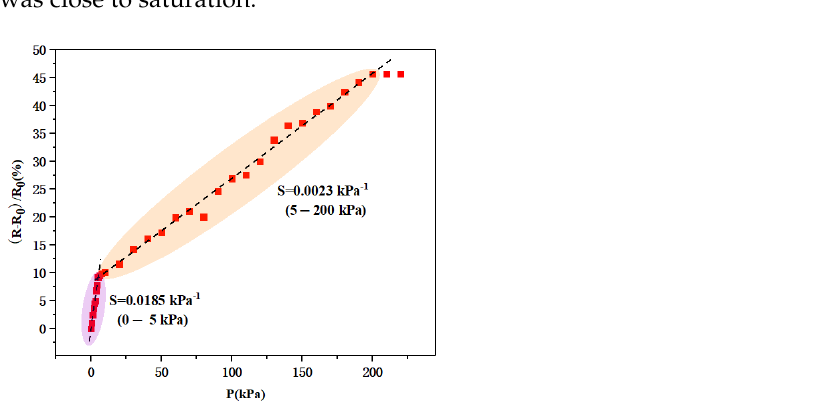
Figure 6. The sensitivity curve for the flexible pressure sensor based on silicon nanomembranes.